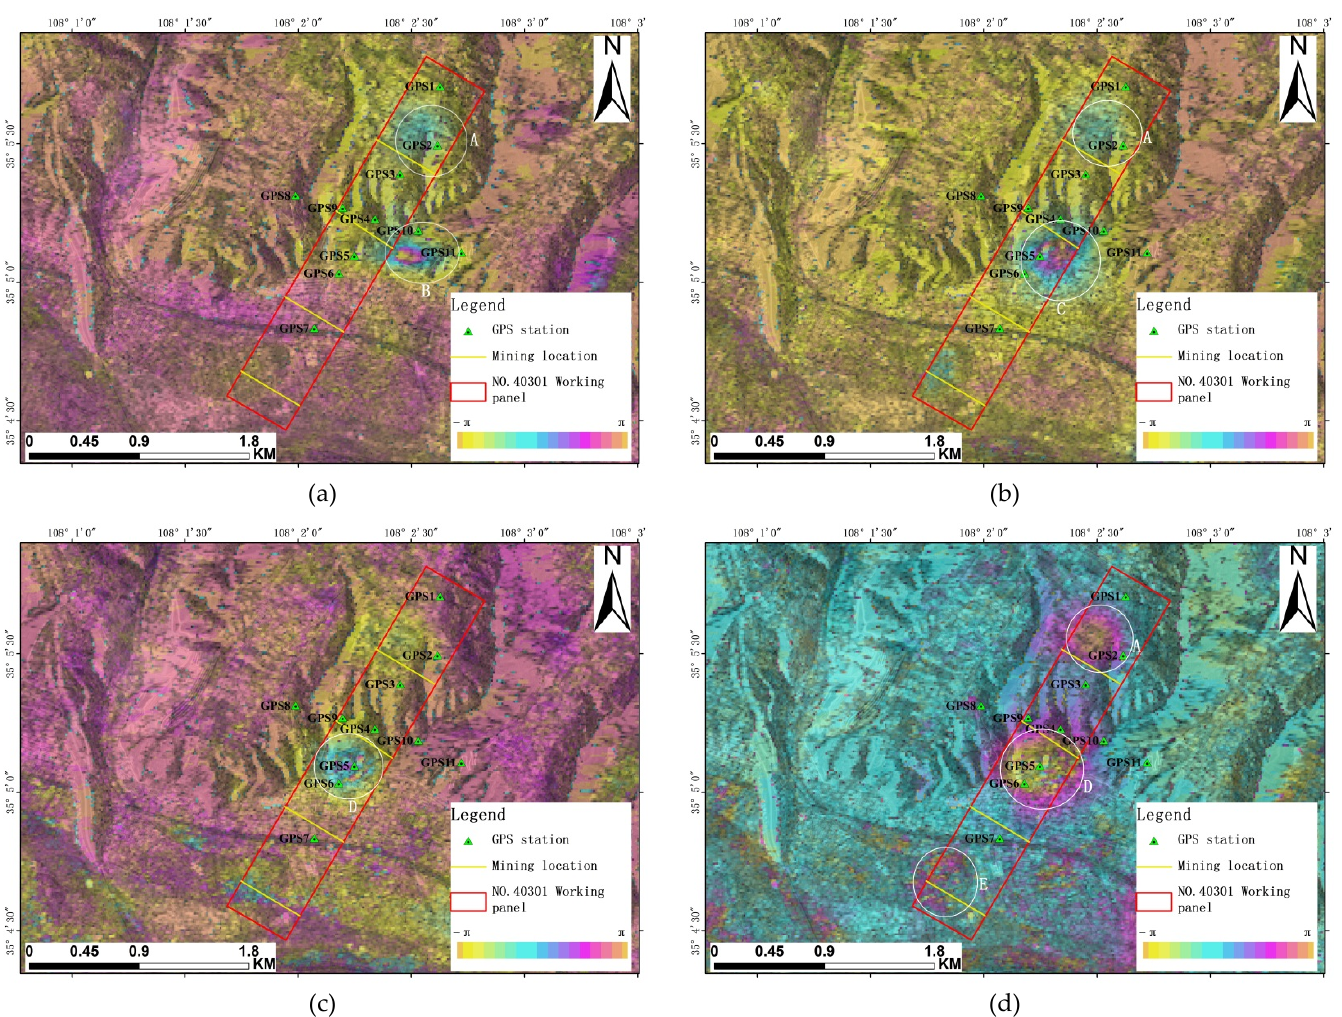
Figure 3. Differential interferometry phase maps: ( a ) the period from 4 July 2007 to 19 August 2007; ( b ) the period from 19 August 2007 to 4 October 2007; ( c ) the period from 4 October 2007 to 19 November 2007; ( d ) the period from 19 November 2007 to 4 January 2008. In the last step of the DInSAR procedure, the differential interferogram phases were transformed into subsidence values and geocoded into the WGS84 projection coordinate system. We acquired four subsidence maps from 4 July 2007 to 4 January 2008. The subsidence values were extracted and overlaid. Consecutive subsidence values of mining were rendered in color, as shown in Figure 4, which displays the total subsidence value for the region over 184 days. Meanwhile, the subsidence regions in each time period are marked by gray oval outlines. They were characterized by forward movement of the footprint of the ground surface in the mining area, i.e., surface subsidence caused by underground mining. The subsidence value continuously increased and the deformation area gradually expanded toward the southern direction—the same direction as mining expansion. As of January 2008, the ground surface formed three mining ‐ induced subsidence bowls and a critical bowl located in the middle of the working panel. 4.2. Prediction Results The consecutive subsidence monitoring data acquired from the DInSAR dataset (Table 1) were used to conduct subsidence prediction. There were 11 GPS stations above the working panel (see Figure 1), selected as prediction objectives. The GPS monitoring results could then be used as